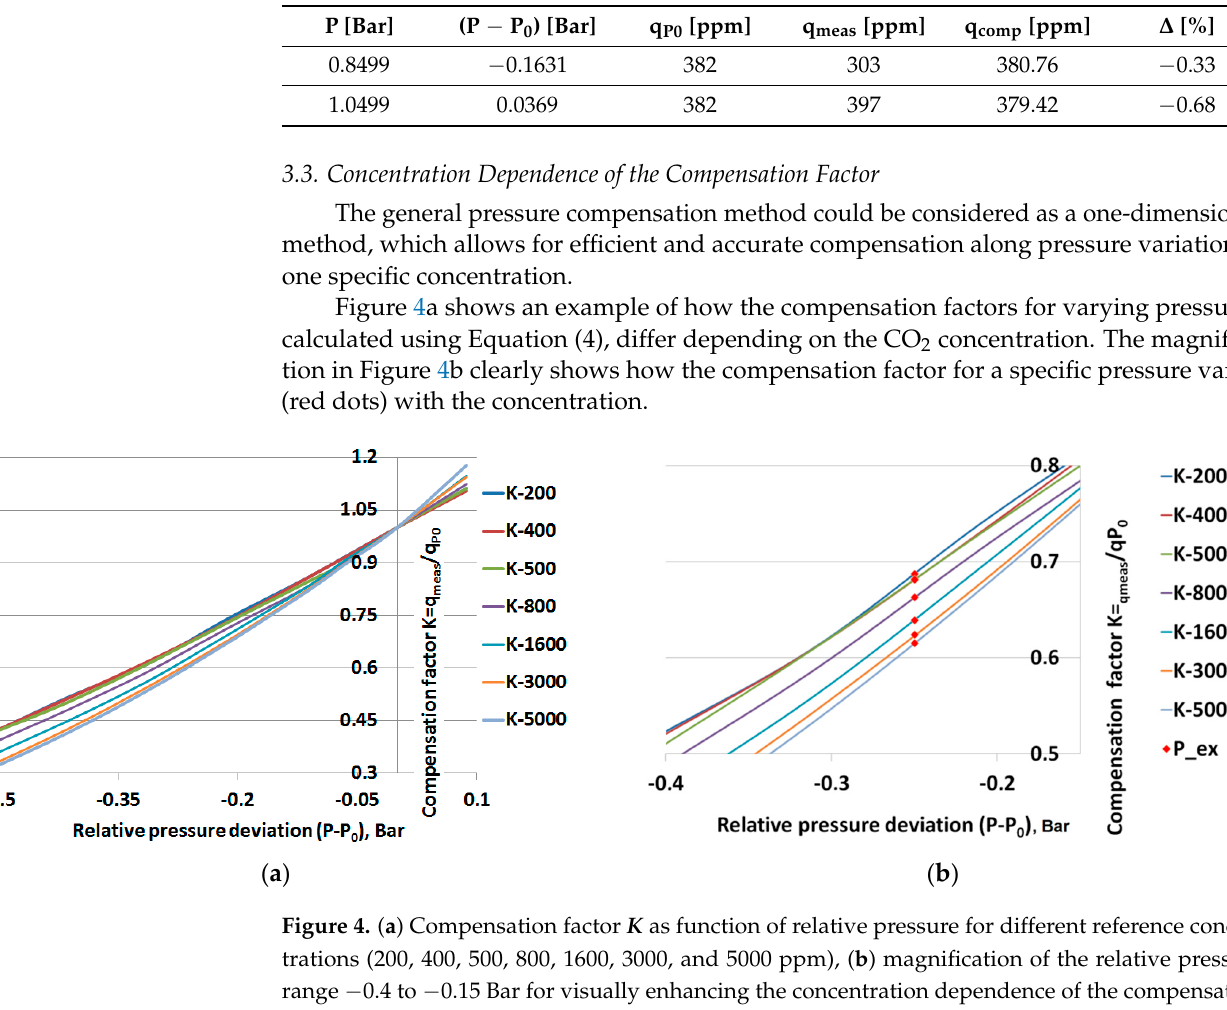
Table 1. Verification of the compensation algorithm performed on two arbitrary pressure points.